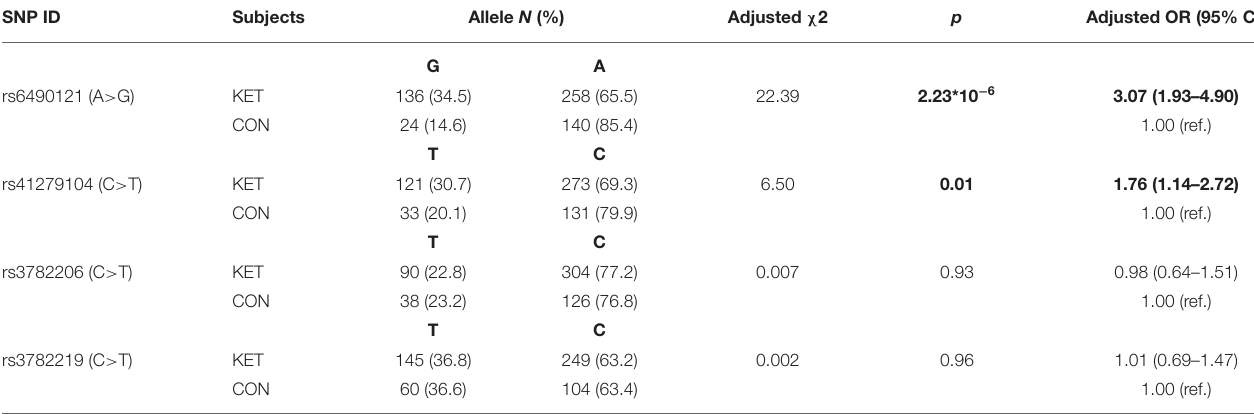
TABLE 3 | Allele frequency of the NOS1 gene in ketamine users vs. control